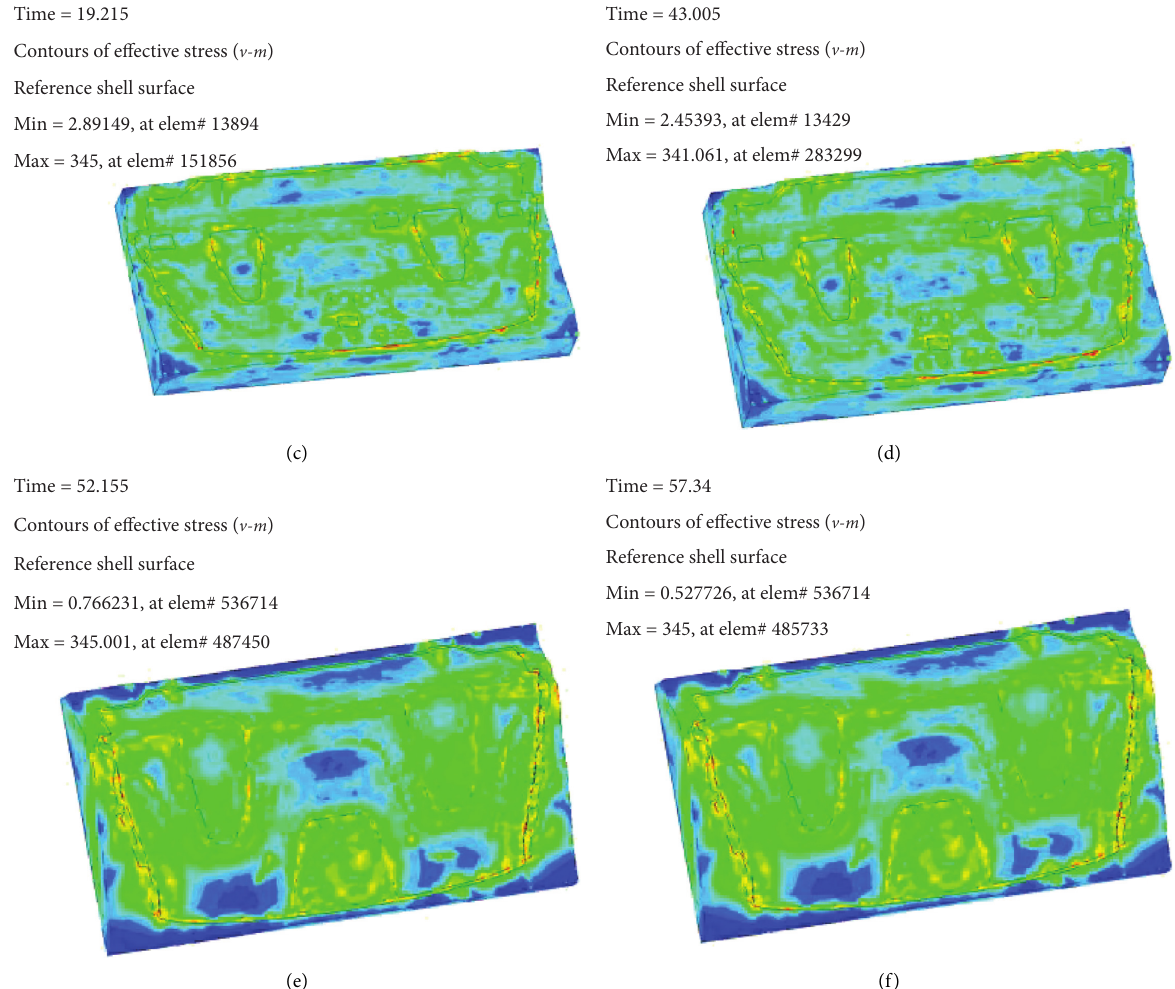
Figure 6: Cloud diagram of stress changes during the packing process.